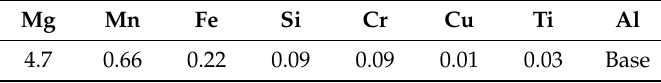
Table 1. Chemical composition of samples (in